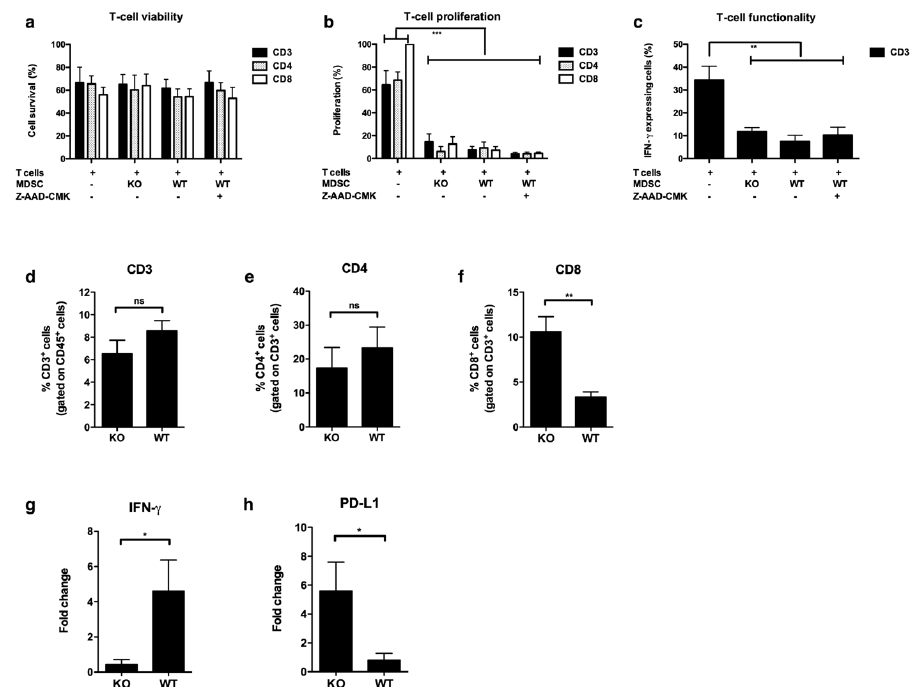
Figure 6. Perforin and GzmB expressing how MDSCs affect CD8 + T-cell numbers in the tumor microenvironment (TME). ( a – c ) Carboxyfluorescein succinimidyl ester (CFSE)-labeled T-cells were activated with anti-CD3 / CD28 antibody coated beads and cultured without MDSCs, with KO MDSCs or with WT MDSCs in the presence or absence of the GzmB inhibitor, Z-AAD-CMK. A MDSC:T-cell ratio of 1:2 was used. ( a ) Summarizing graph showing the viability of T-cells measured by flow cytometry as 7-AAD − / Annexin V + cells. ( b ) Summarizing graph showing the inhibition of T-cell proliferation measured by flow cytometry as reduced CFSE dilution. ( c ) Summarizing graph showing interferon- γ (IFN- γ ) secretion by T-cells measured by flow cytometry. The mean +/ -SEM of at least three experiments is shown in all graphs. For ( a ) and ( b ), a two-way ANOVA was used to calculate the statistical significance, while for ( c ), a one-way ANOVA was used. The number of asterisks in the figures indicates the level of statistical significance as follows: **, p < 0.01 and ***, p < 0.001. ( d – f ) Summarizing graphs showing the % of ( d ) CD3, ( e ) CD4, or ( f ) CD8 T-cells, as measured by the flow cytometry in single cell suspensions of tumors (502 ± 103 mm 3 ) that were grown in vivo starting from B16F10-Fluc cells co-injected with WT or KO MDSCs. ( g – h ) Summarizing graph showing the fold change, as measured by quantitative PCR of ( g ) IFN- γ and ( h ) Programmed Death- Ligand 1 (PD-L1) expression tumors (502 ± 103 mm 3 ) that were grown in vivo, starting from B16F10-Fluc cells co-injected with WT or KO MDSCs. The fold change was normalized to B16F10-Fluc tumors that were grown after injection of tumor cells alone. The graphs show the mean ± SEM of at least three data points. Experiments were performed twice. A student’s t-test was used to calculate the statistics. Number of asterisks in the figures indicates the level of statistical significance as follows: ns, > 0.05, *, p < 0.05 and **, p < 0.01.